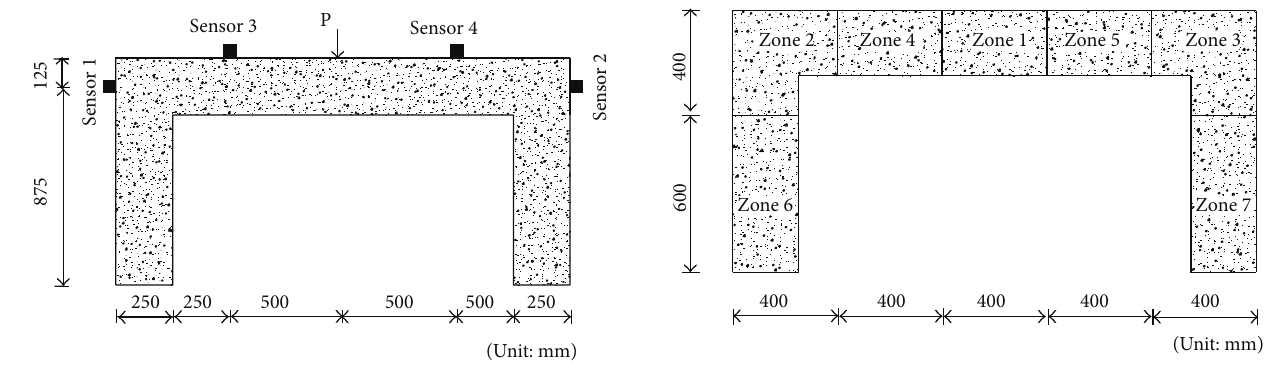
Figure 3: Detail and dimension of specimen